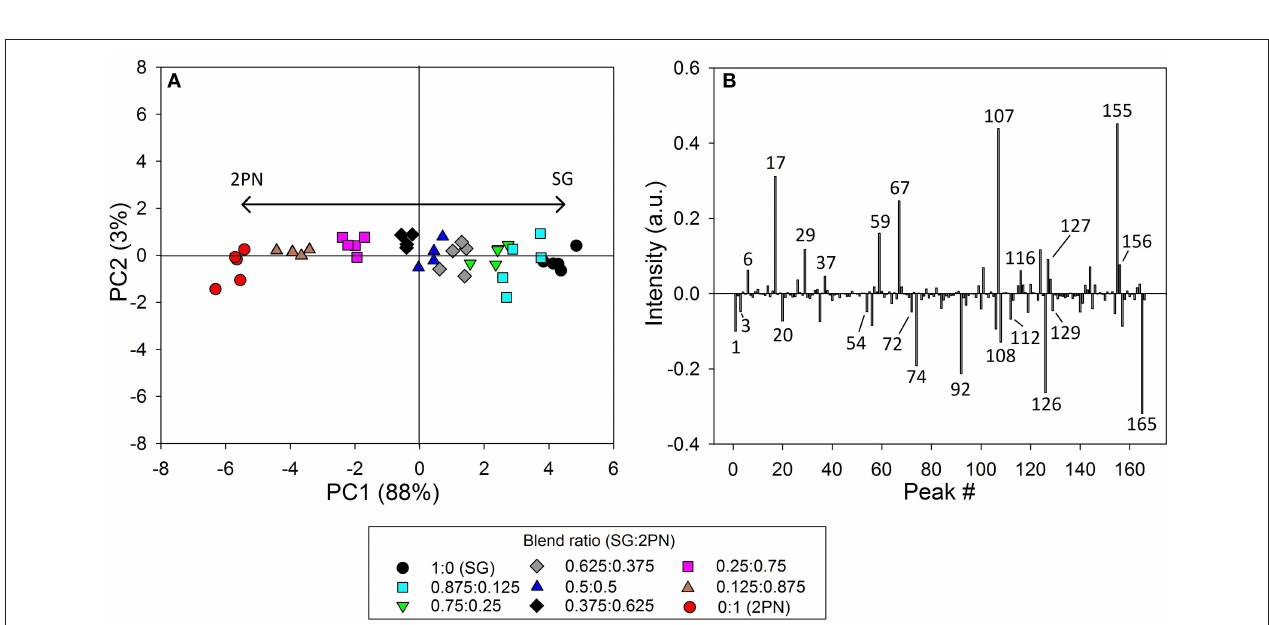
FIGURE 3 | Principal component analysis (PCA) of Py-GC/MS pyrograms from switchgrass (SG), 2 ′′ pine residues (2PN), and their corresponding blends; the PC1 vs. PC2 scores plot (A) , and the PC1 loadings plot (B) are shown.